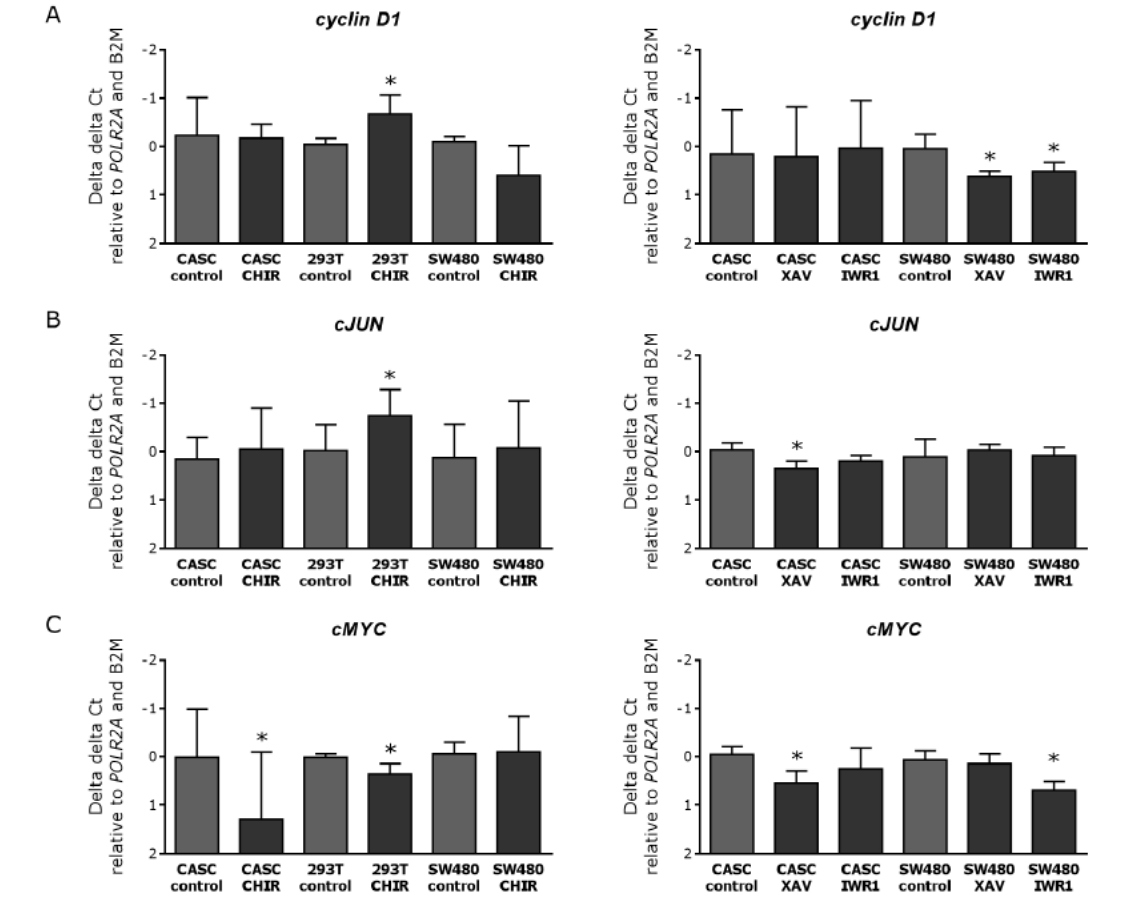
Figure 7. Wnt stimulation and inhibition in CASCs have no clear effect on the expression of proliferation-associated genes. mRNA expression of the Wnt proliferation-associated target genes ( A ) Cyclin D1 , ( B ) cJUN , and ( C ) cMYC after Wnt stimulation (left panels) and inhibition (right panels) in CASCs. Data are shown as medians ± IQR ( n = 6 individual patient CASC cultures/condition); * p < 0.05 compared to respective